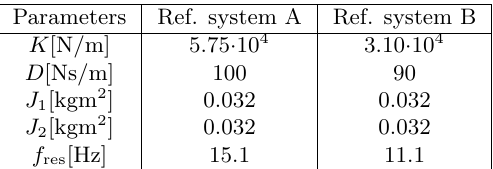
Table 1: Parameters of reference